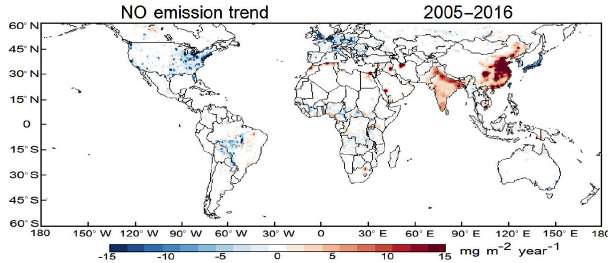
Figure 2. Trends in MERRA-2 GMI NO emissions (units mgm − 2 yr − 1 ) for